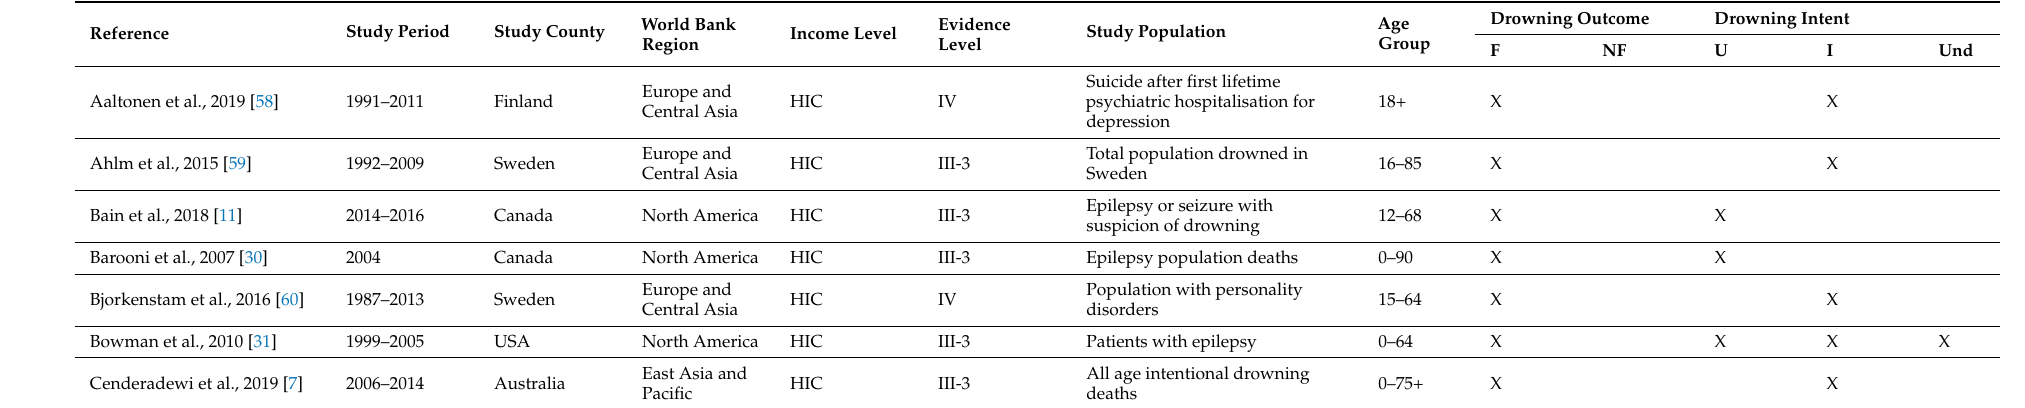
Table A2. Characteristics of Included Studies (n =